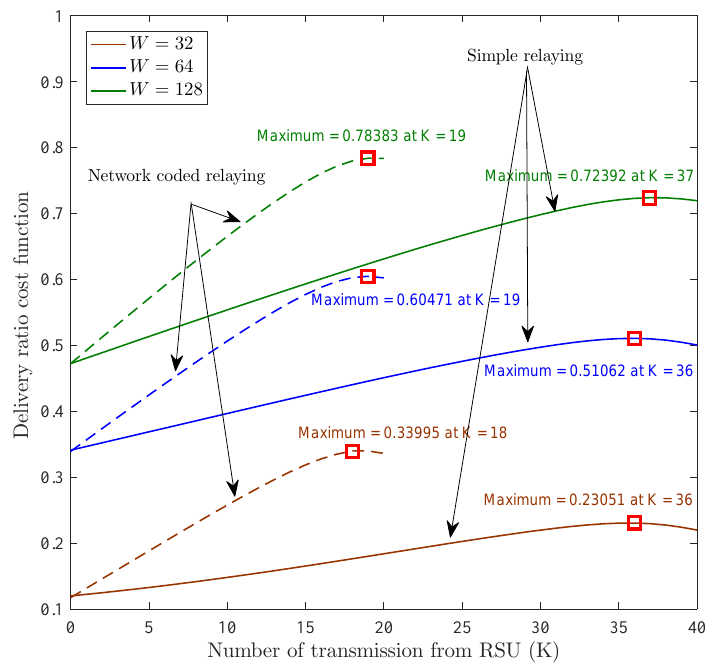
Figure 8. Delivery-ratio cost function with simple relaying and network-coded relaying schemes considering packet collision in the network. The solid lines correspond to simple relaying scheme, while the dotted lines represent network-coded relaying